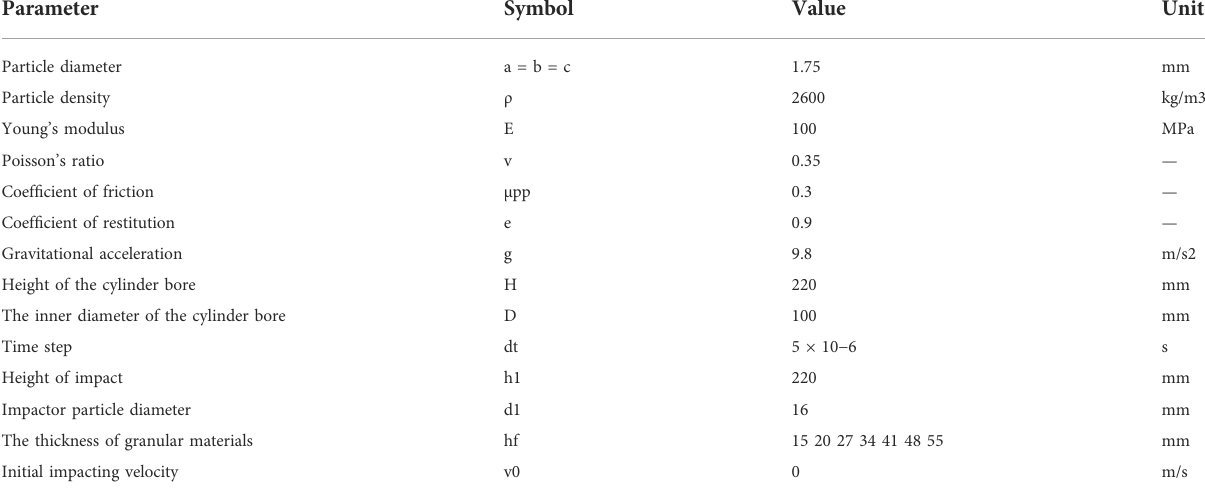
TABLE 1 Simulation parameters used in the discrete element method